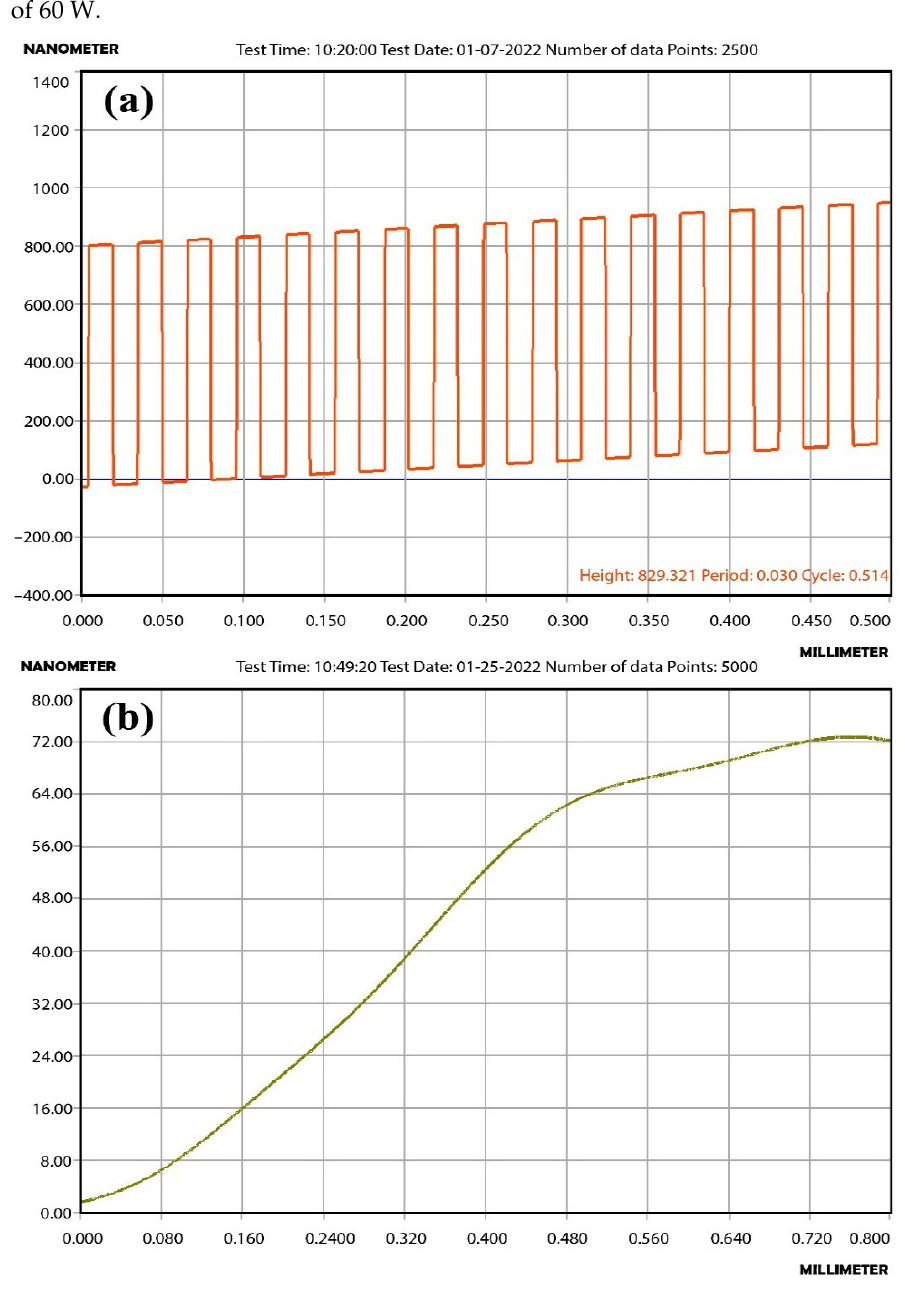
Figure 5. ( a ) The thickness measurement results of the interdigitated electrodes and ( b ) the ZnO<La> film.